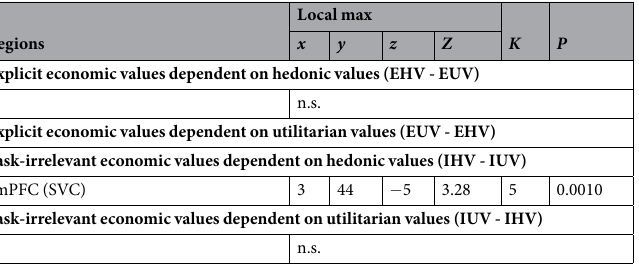
Local max Regions K Px y z Z Explicit economic values dependent on hedonic values (EHV - EUV) n.s. Explicit economic values dependent on utilitarian values (EUV - EHV) Task-irrelevant economic values dependent on hedonic values (IHV - IUV) vmPFC (SVC) 0.0010 n.s. Table 3. Neural value-type specific representation. Brain areas showing explicit value representations dependent on hedonic values (EHV-EUV) and utilitarian values (EUV-EHV), and task-irrelevant value representations dependent on hedonic values (IHV-IUV) and utilitarian values (IUV-IHV). The uncorrected threshold was uncorrected p < 0.0001, and was corrected to p < 0.05 using cluster size. Coordinates are reported in the stereotaxic space of the MNI. Abbreviations: vmPFC (ventromedial prefrontal cortex); VS (ventral striatum); SVC (small volume correction); EUV (explicit utilitarian values); IHV (task-irrelevant hedonic values); EHV (explicit hedonic values); IUV (task-irrelevant utilitarian values); n.s. (non-significant); MNI (Montreal Neurological